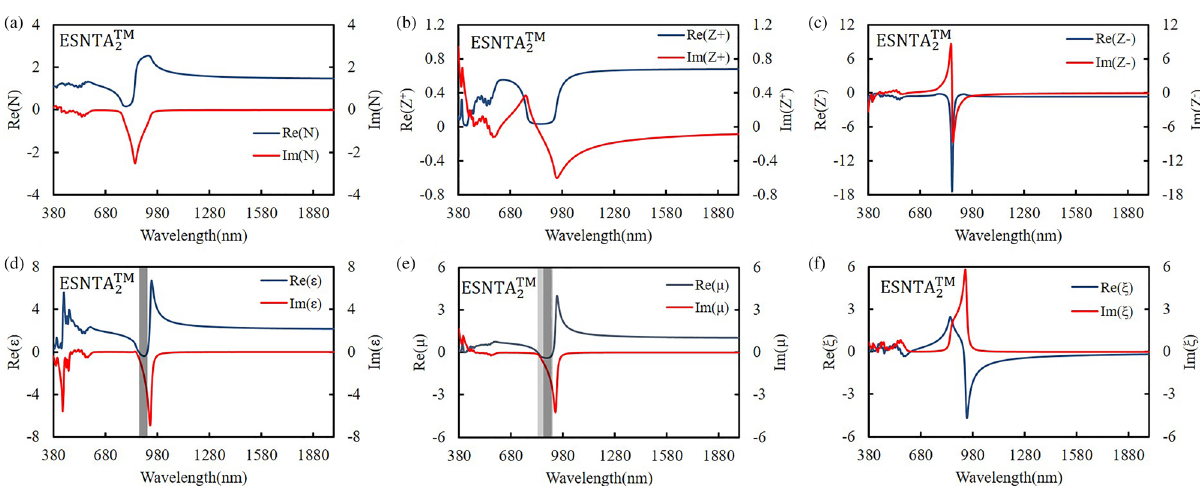
Figure 9. Retrieved ( a ) refractive index, ( b ) positive impedance, ( c ) negative impedance, ( d ) permittivity, ( e ) permeability, and ( f ) bianisotropy parameter for ESNTA 2TM